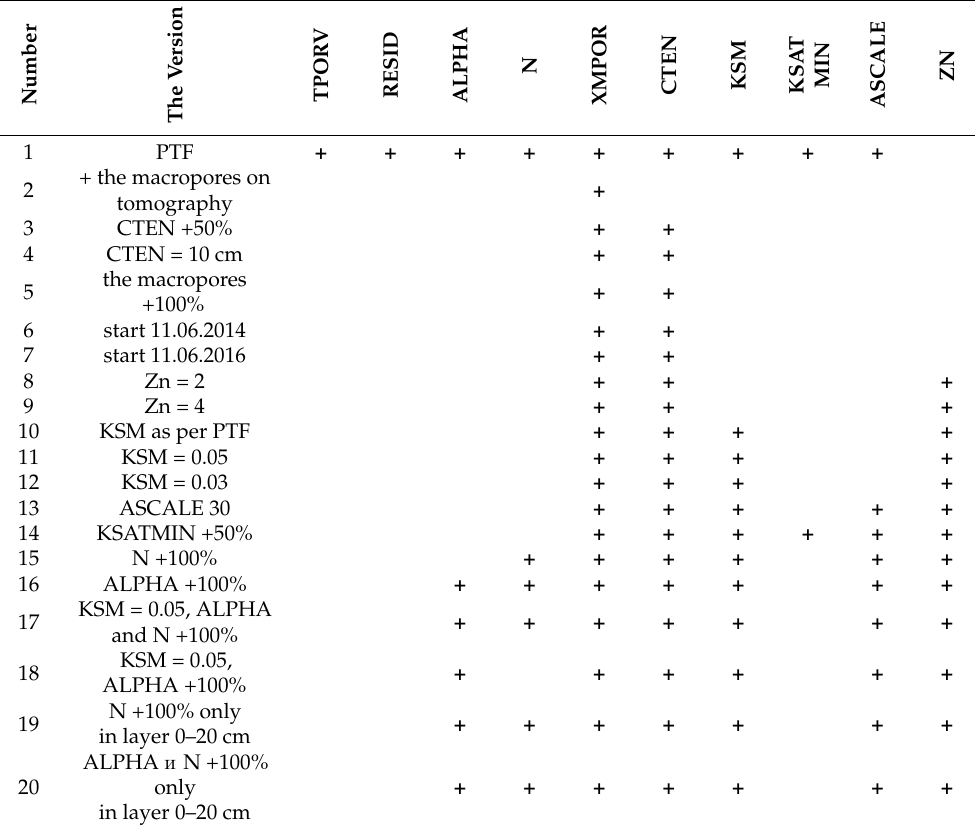
Table 3. Hydraulic parameters used as MACRO 5.2 input and parameters to be calibrated (marked by plus).